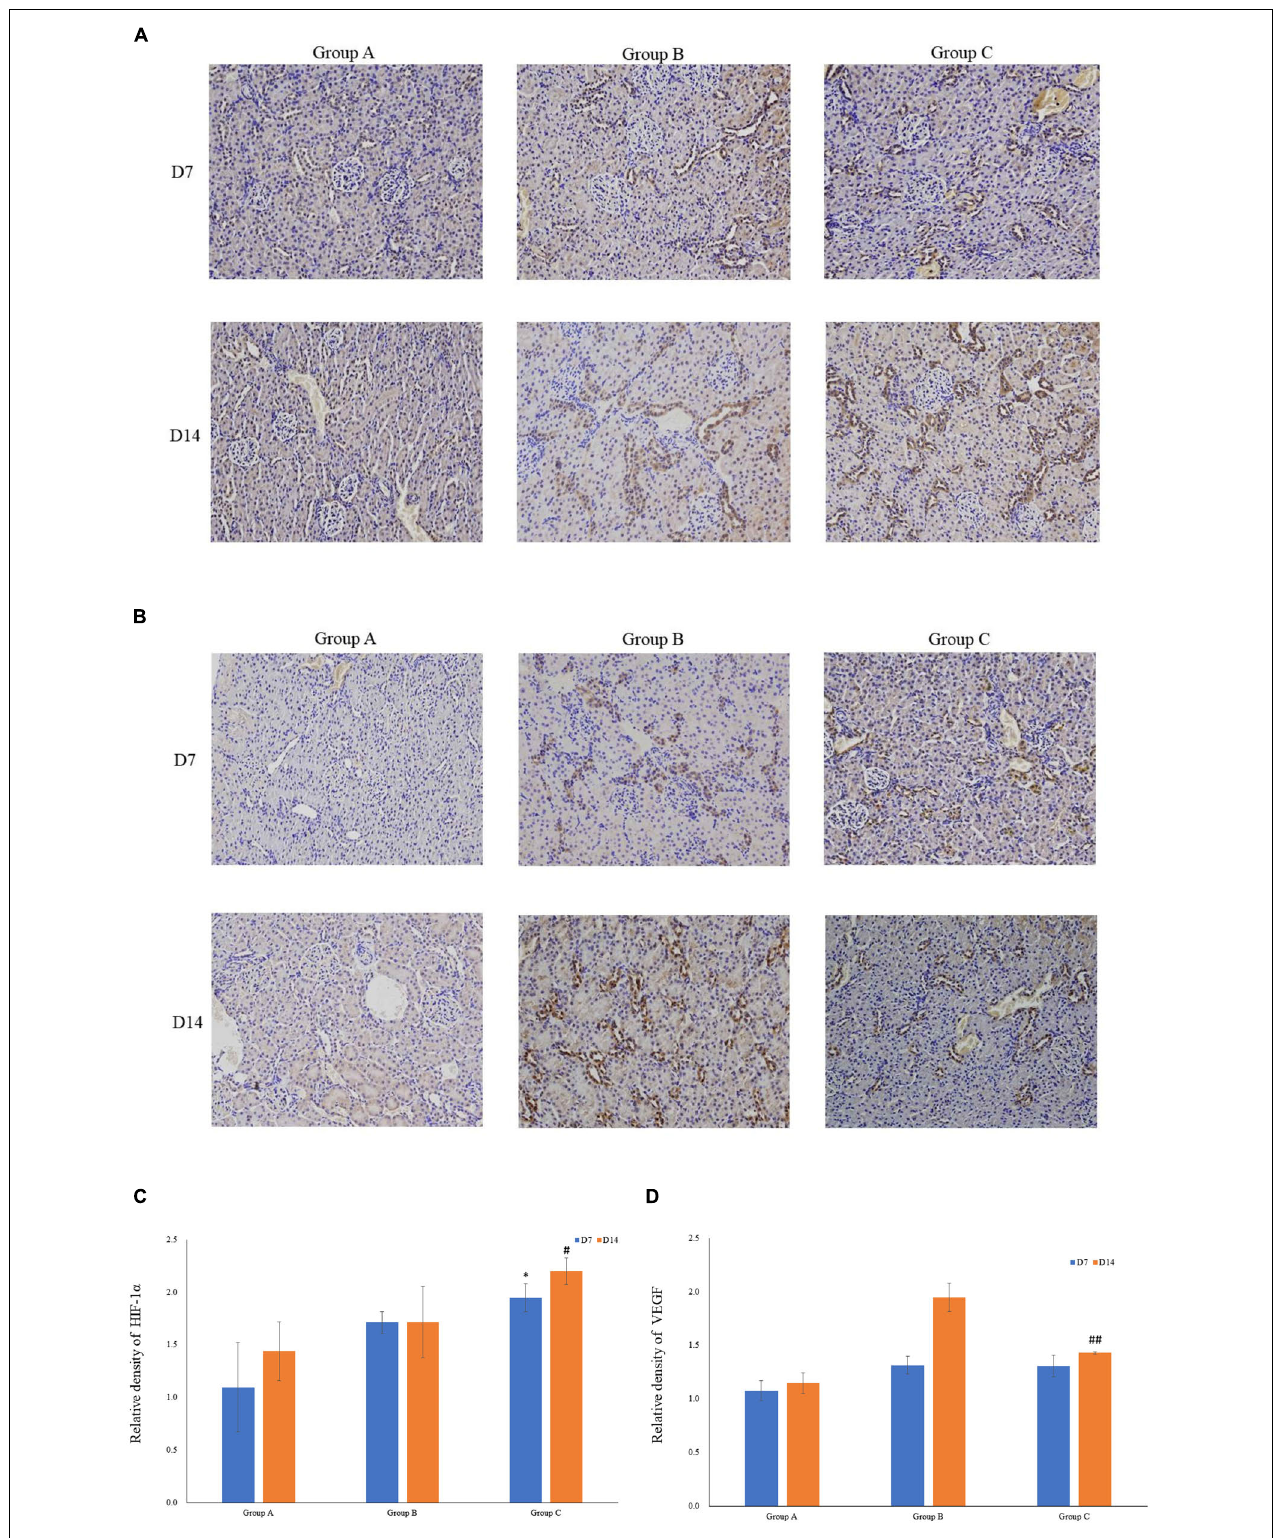
FIGURE 5 | The expression levels of HIF-1 α and VEGF in rat kidneys. (A) Localization of HIF-1 α expression in kidneys (immunohistochemistry; original magnification: × 200). (B) Localization of VEGF expression in kidneys (immunohistochemistry; original magnification: × 200). (C) Relative levels of HIF-1 α . (D) Relative levels of VEGF. ∗ P < 0.05 vs. group A1; # P < 0.05 vs. group A2; ## P < 0.05 vs. group B2, respectively.